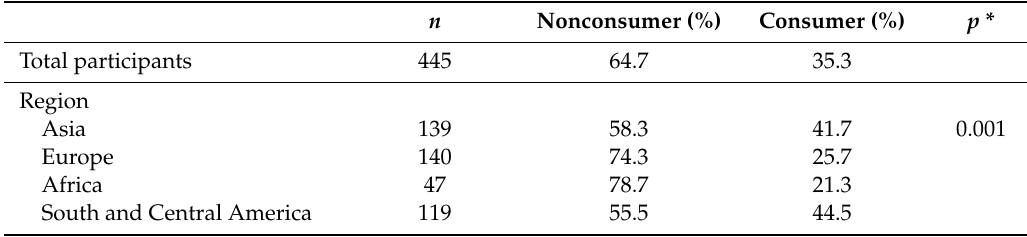
Table 4. Functional food consumption classified by geographical region.